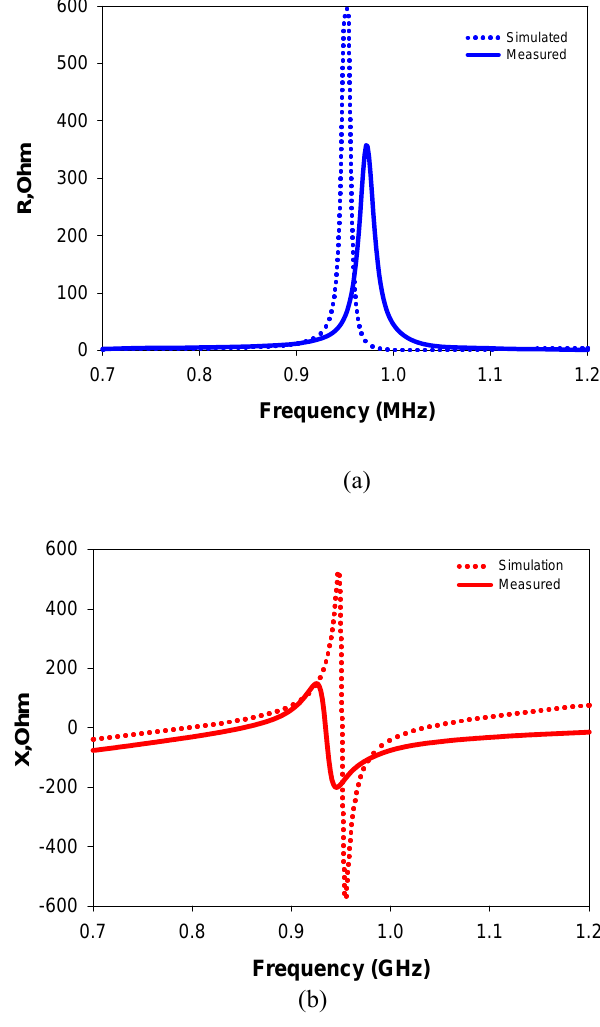
Figure 7: Measured and simulated input impedances of the prototype RFID tag antenna, (a) Resistance, (b) Reactance.